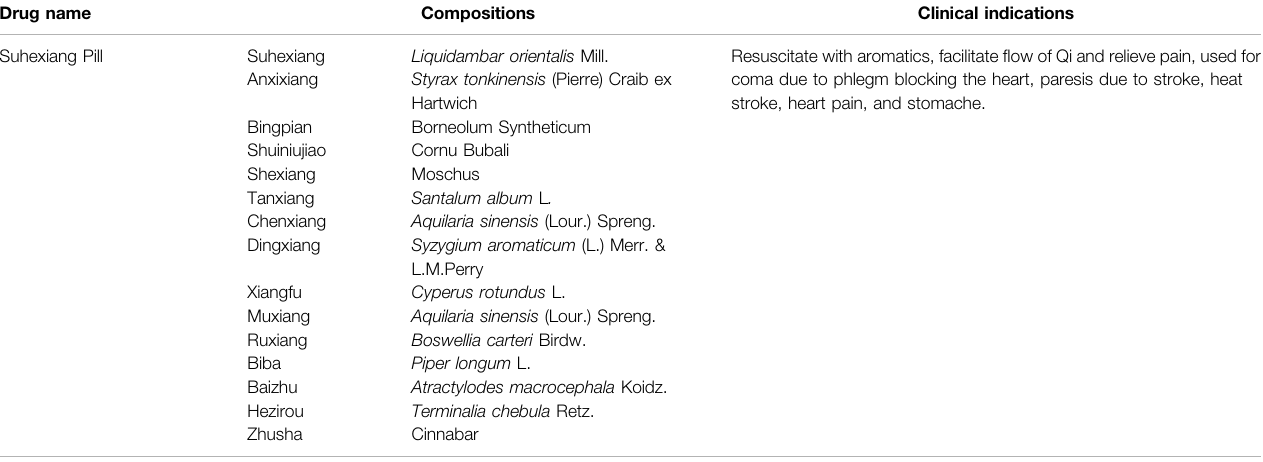
TABLE 1 | ( Continued ) Summary of recommended oral CPMs in the Guidelines on Diagnosis and Management of